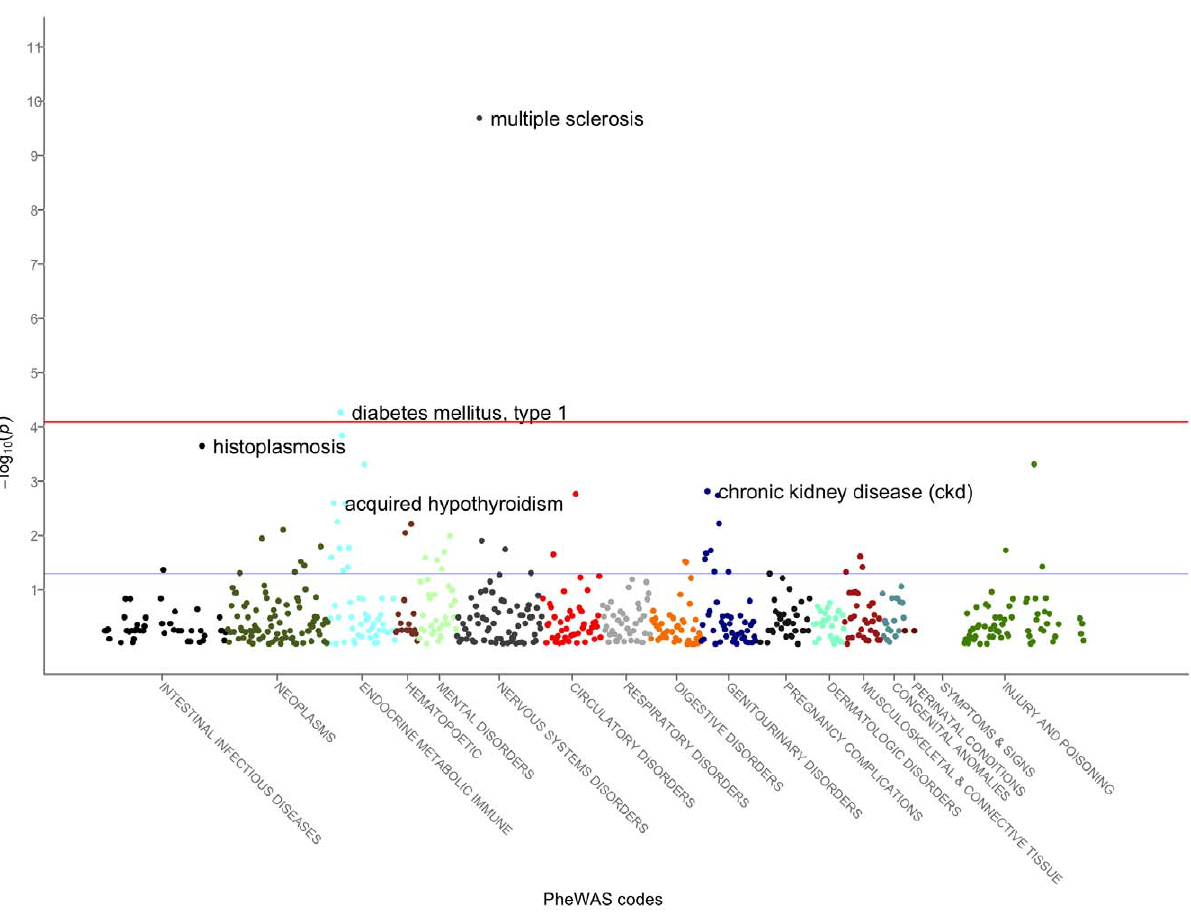
Figure 5. A PheWAS plot for rs3135388 in HLA-DRA. This region has known associations with multiple sclerosis. The red line indicates statistical significance at Bonferroni correction. The blue line represents p , 0.05. This plot is generated from updated data from [78] and the updated PheWAS methods as described in [73].